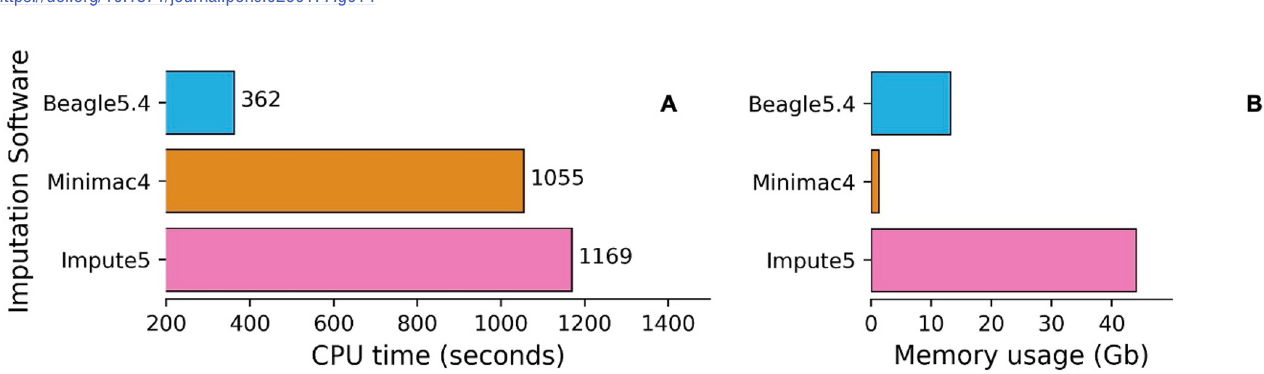
Fig 14. CPU run time and memory usage of imputation software for Affymetrix, Omni, Customized datasets. Average run time for imputation (A) tools. Average memory usage for imputation (B) tools in chips dataset.